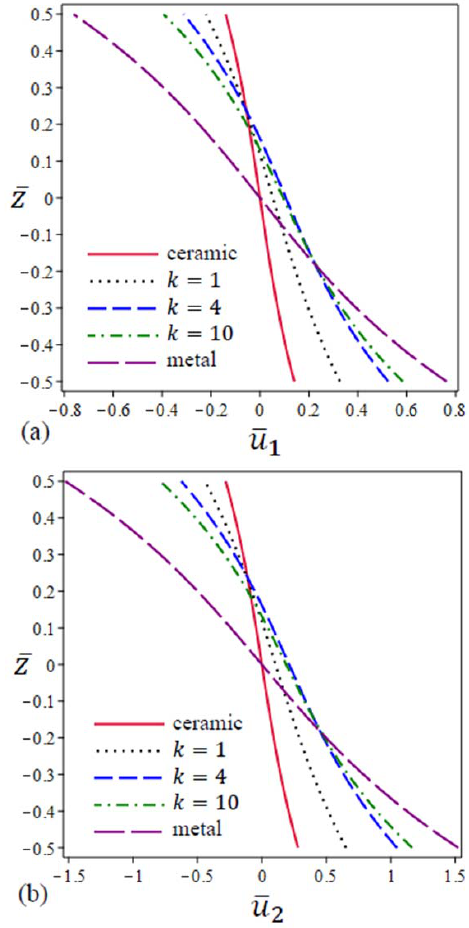
Figure 7: The in-plane displacements across the thickness of a FG plate: (a) u 1 , (b) u 2 .